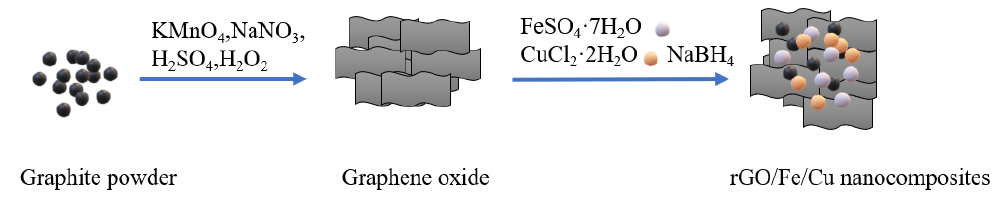
Figure 1. Schematic of rGO/Fe/Cu nanocomposite synthesis.